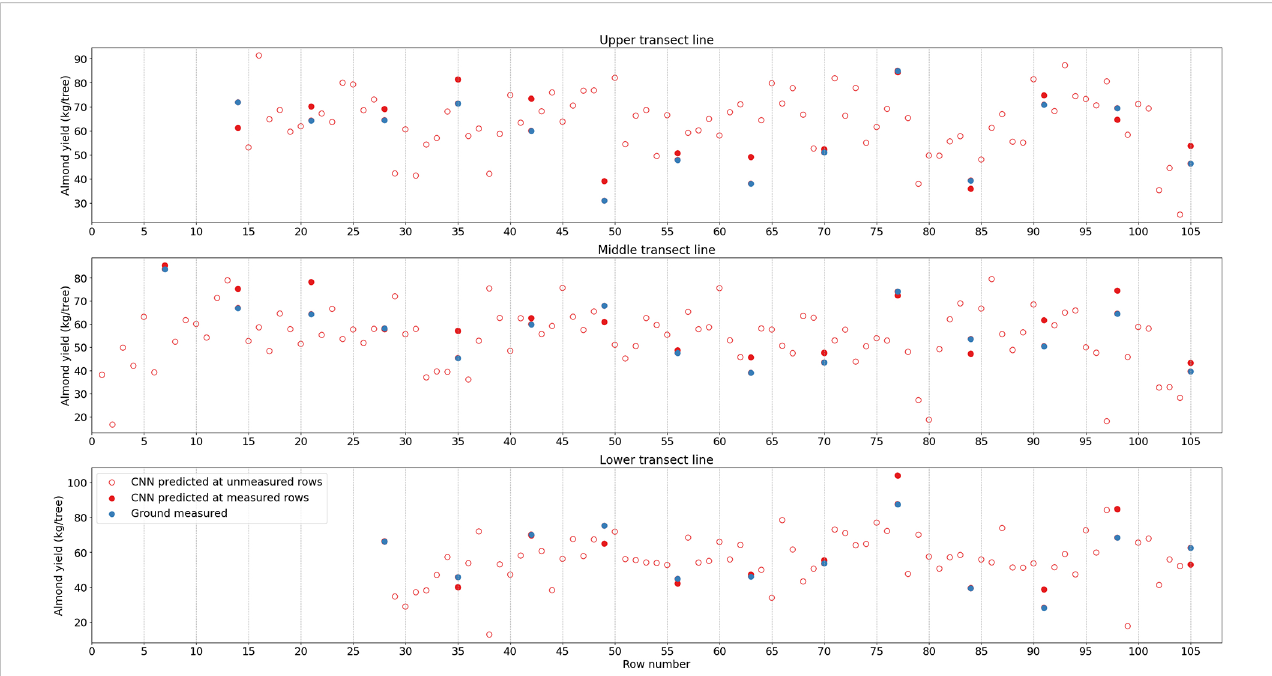
FIGURE 9 Almond yield variation from tree to tree along three selected transects as shown in Figure 4. CNN-estimated yield is represented by red while harvest data in blue; red open circles are for CNN estimation at rows without individual tree yield